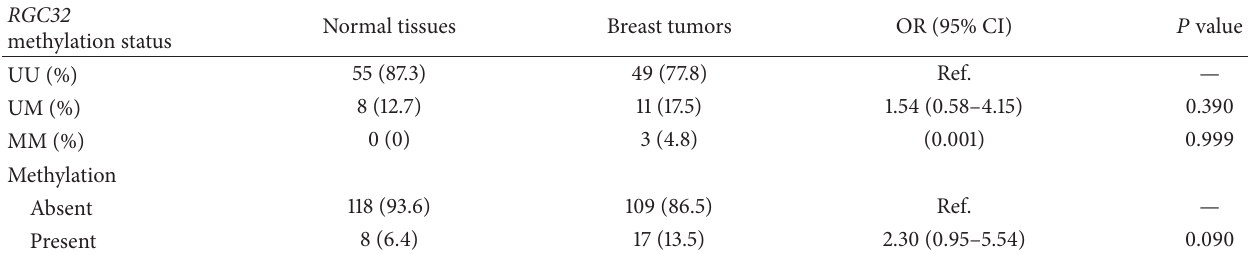
Table 2: Promoter methylation frequency of RGC32 gene in breast cancerous and breast normal tissues.